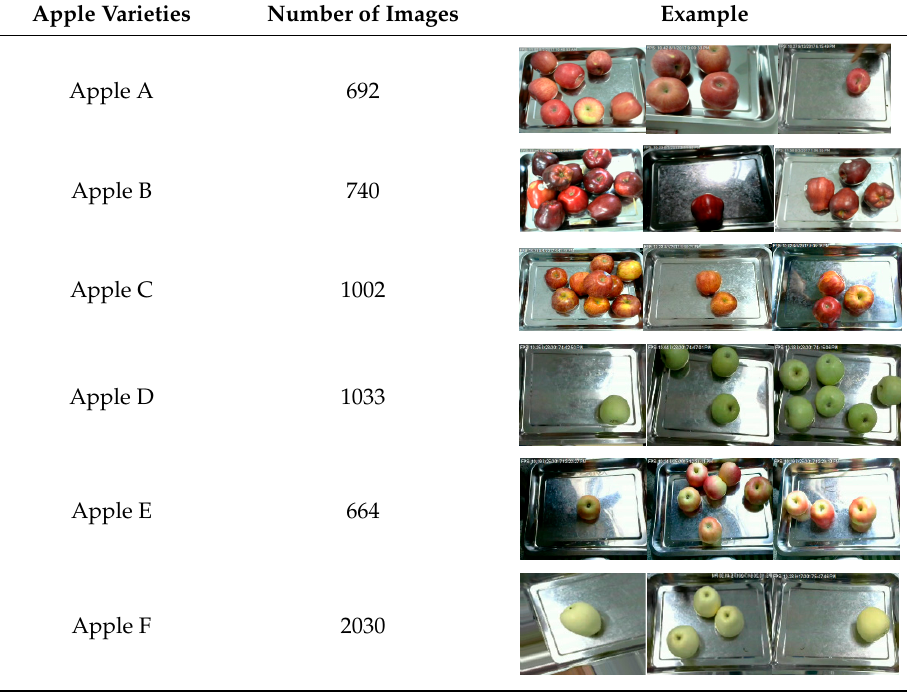
Table 3. Dataset structure considered in the research.